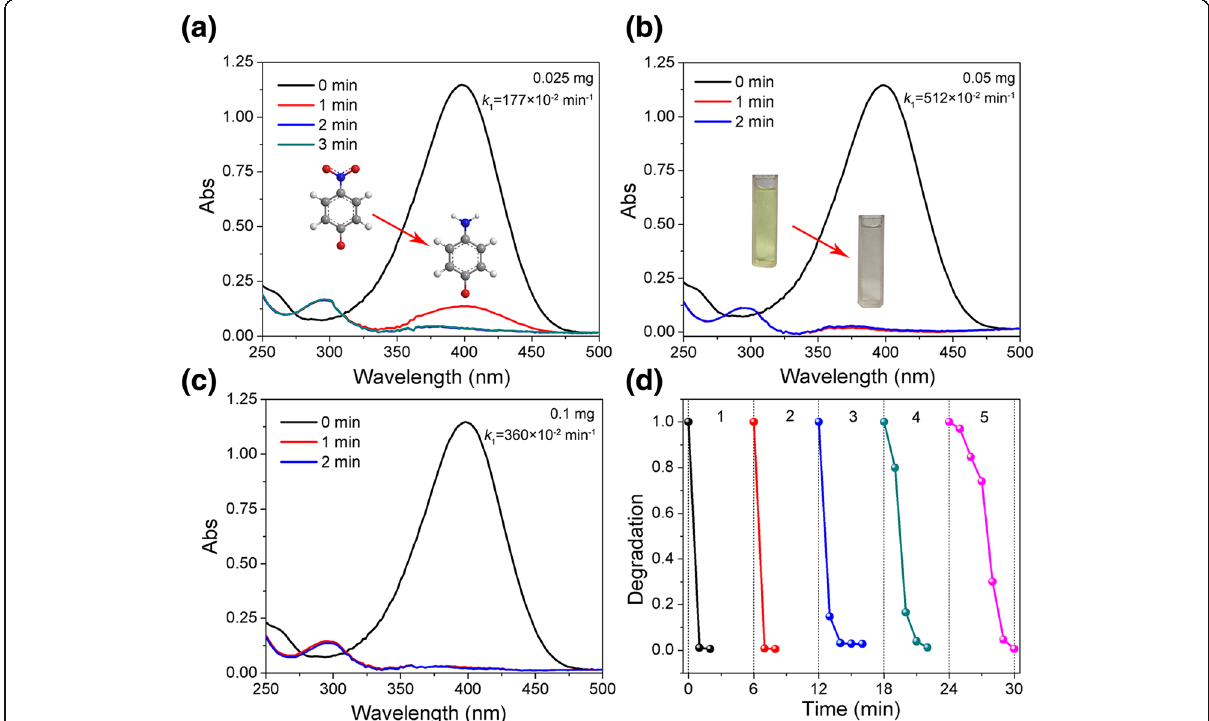
Fig. 7 Time-dependent UV-vis spectrum and corresponding k 1 values of Nip with a 0.025 mg, b 0.05 mg, and c 0.1 mg of S2; the inset in a is the diagram for reaction of Nip to Amp, and the inset in b is the color change of Nip solution after catalytic reaction. d Normalized concentration change of Nip for 5 cycles in the presence of 0.05 mg of